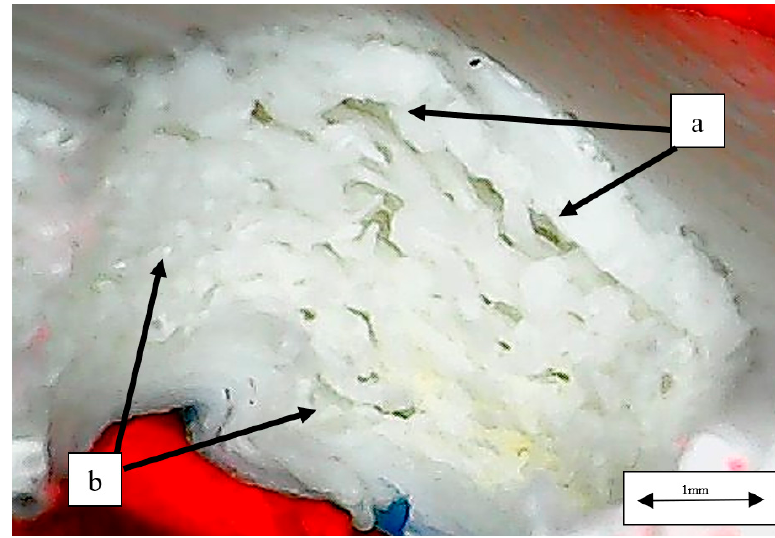
Figure 11. Central hole cross-section of NACA 23015-PLA-D sample: ( a ) delamination at the central hole; ( b ) damages caused by drilling and possible voids.